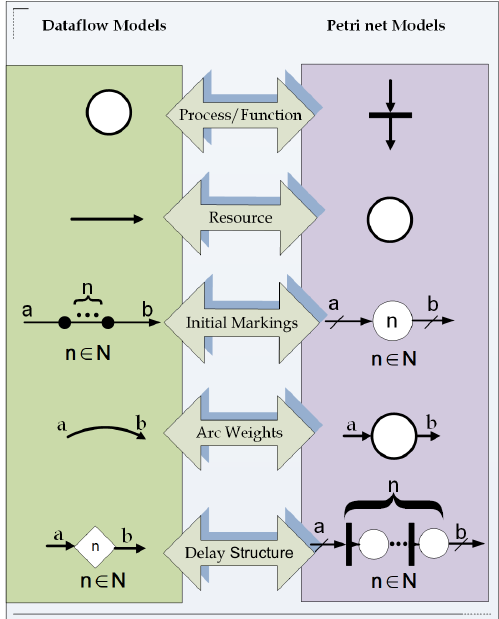
Figure 3. Proposed mapping rules between the engaged model domains (adapted from